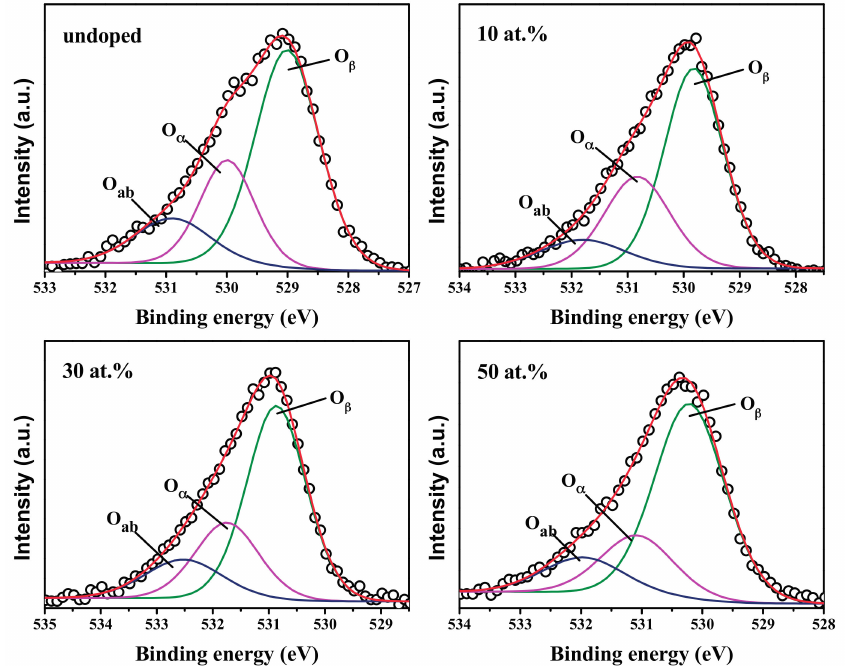
Figure 6. Gaussian deconvoluted X-ray photoelectron spectroscopy (XPS) spectrum of O1s of SnO 2 and FTO NPs.